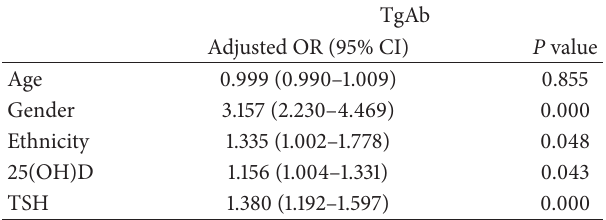
Table 5: Determinants of positive serum thyroglobulin